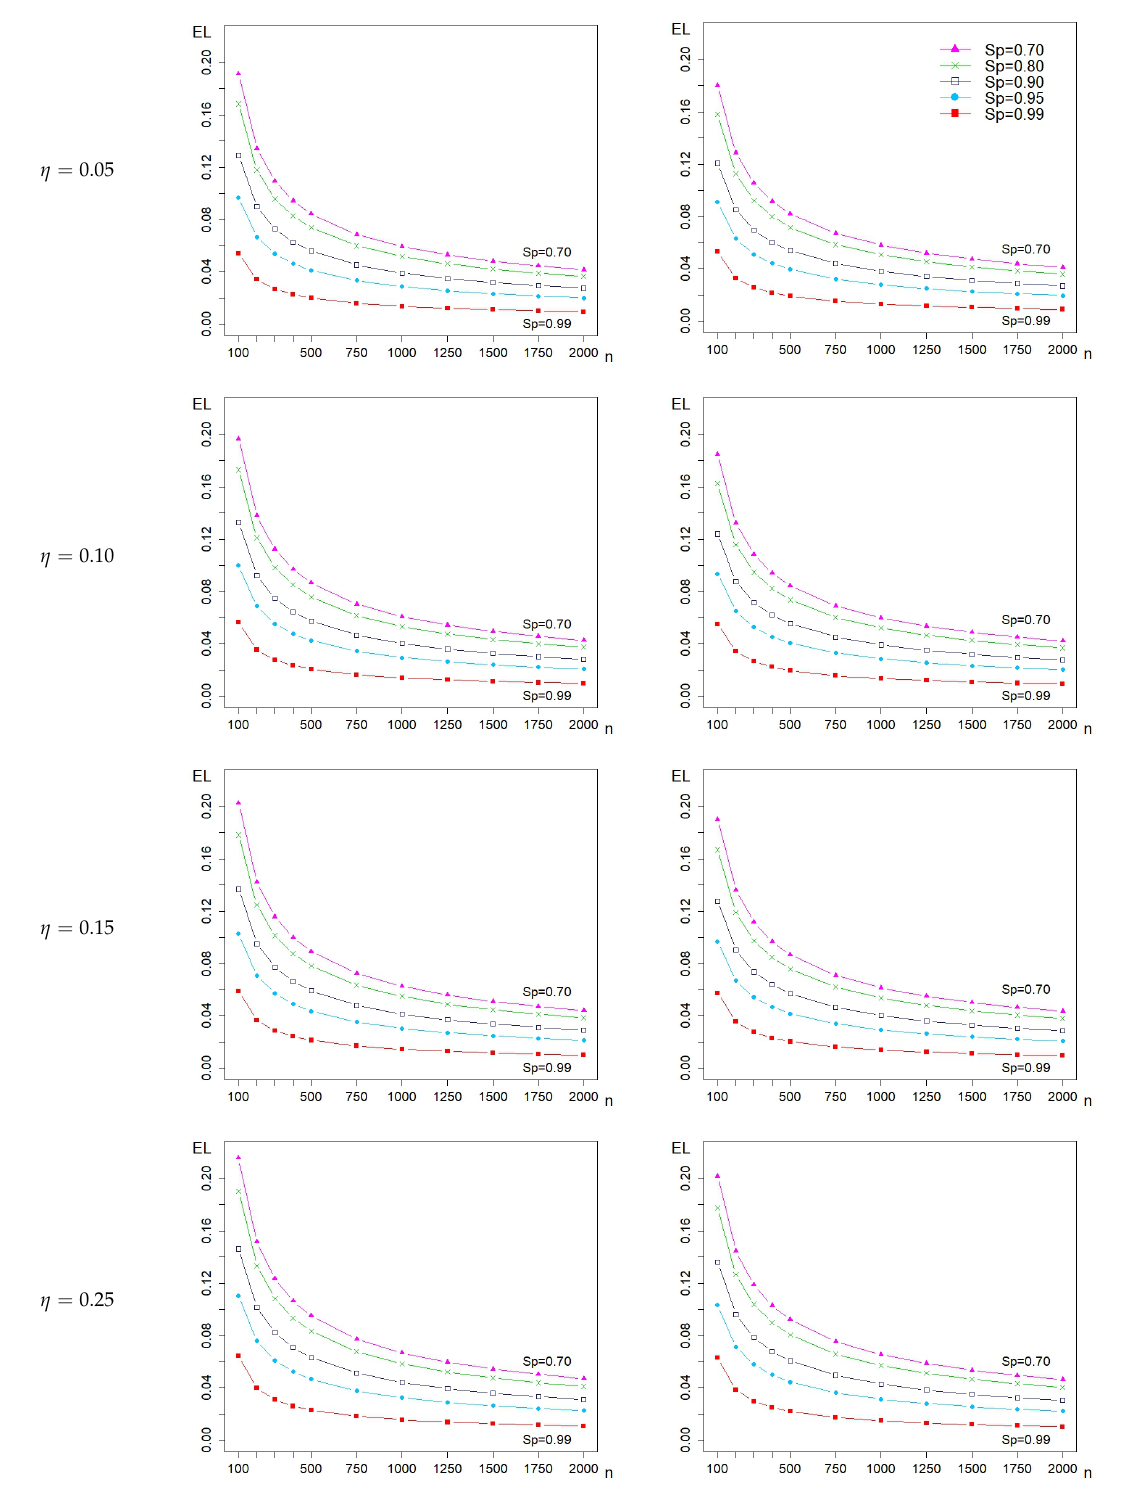
Figure 5. Expected length of specificity intervals varying with the sample size ( n ), for η = 0.05; 0.10; 0.15; 0.25, and Sp = 0.70; 0.80; 0.90; 0.95; 0.99, using Clopper–Pearson and Wilson methods with 95% nominal confidence